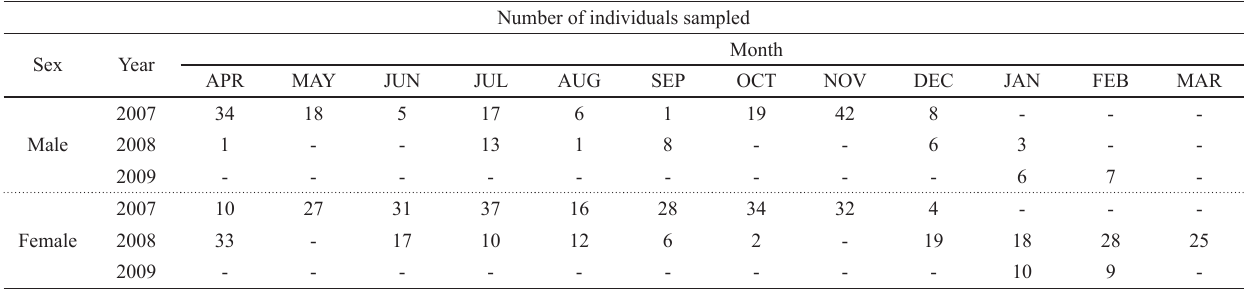
Tab. 1. Number of individuals sampled for estimating the reproductive indexes of Sympterygia bonapartii from San Matías Gulf (Argentina).